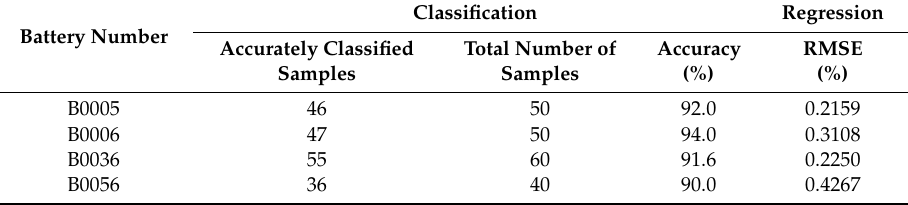
Table 5. Classification and estimation results of different batteries using features of PDD.